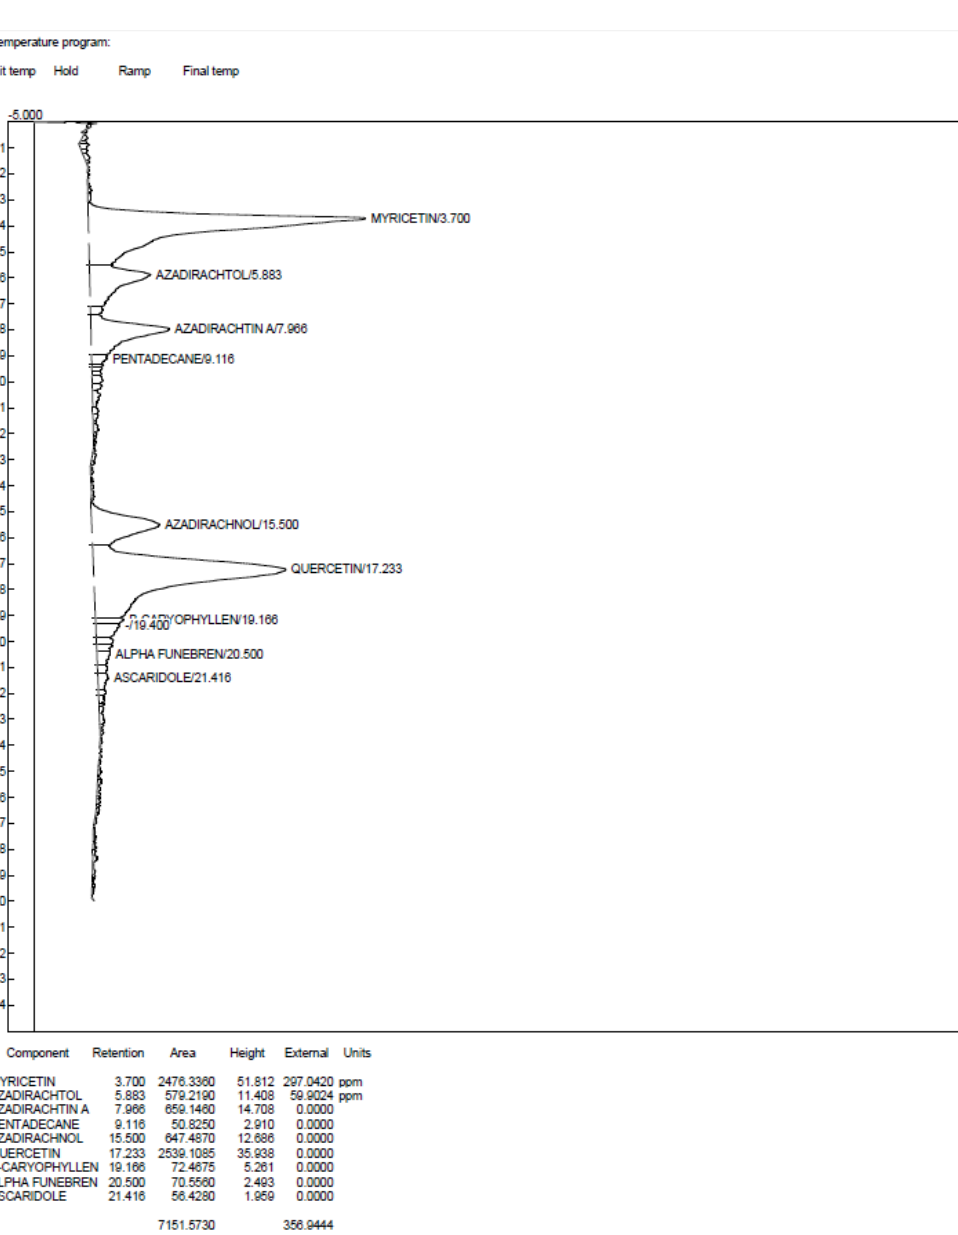
Figure 7. Chromatogram of ethylacetate extract of A. indica